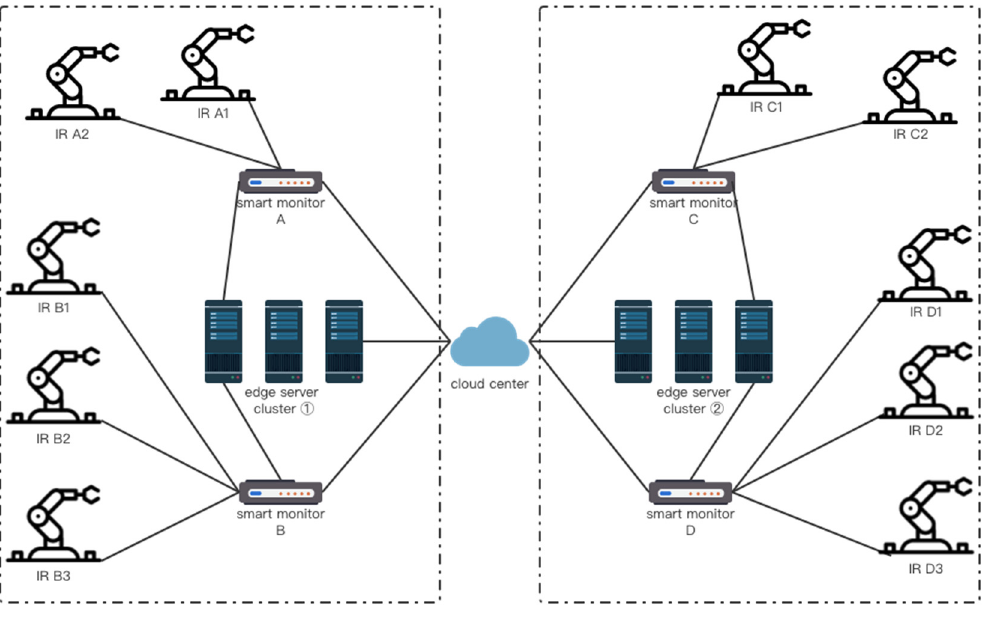
Figure 1. IRMS Edge–Cloud Architecture.